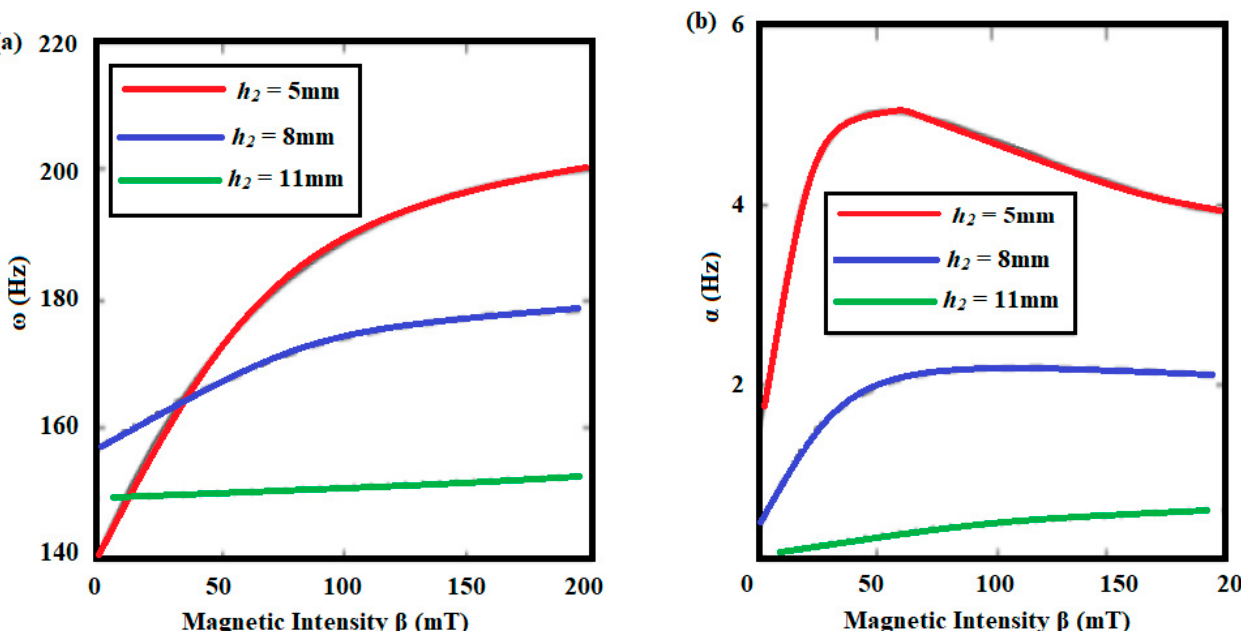
Figure 15. ( a ) Natural frequency ω and ( b ) damping ratio α vs. magnetic intensity β for various values of MRE thickness.